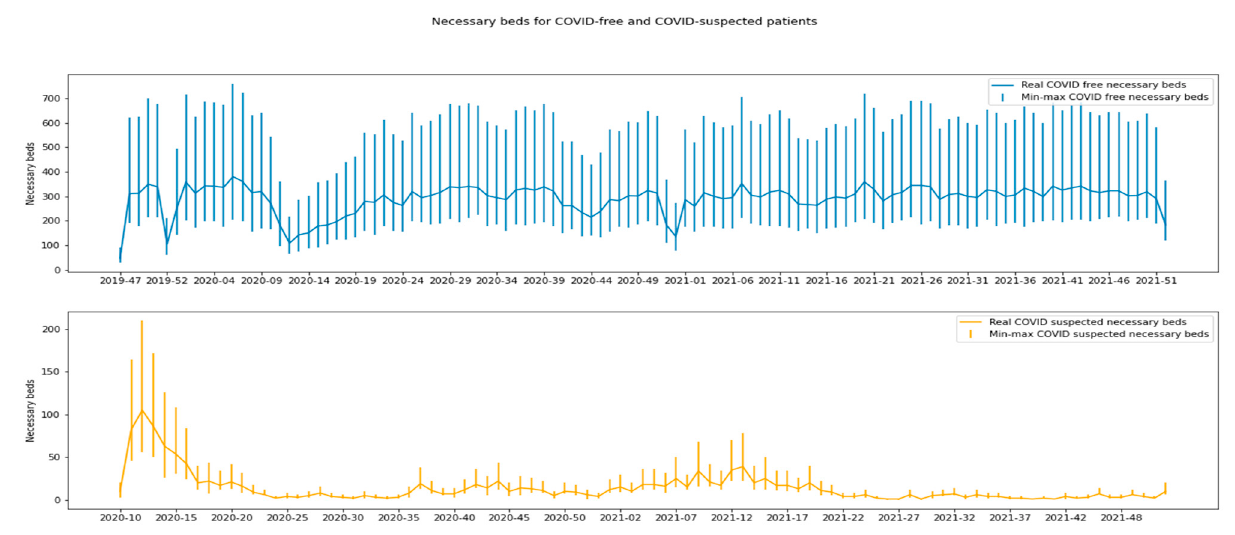
Figure 3. Beds required for presumed non-COVID-19 patients and suspected COVID-19 patients by week, as used by the bed manager to optimize organization of the wards.